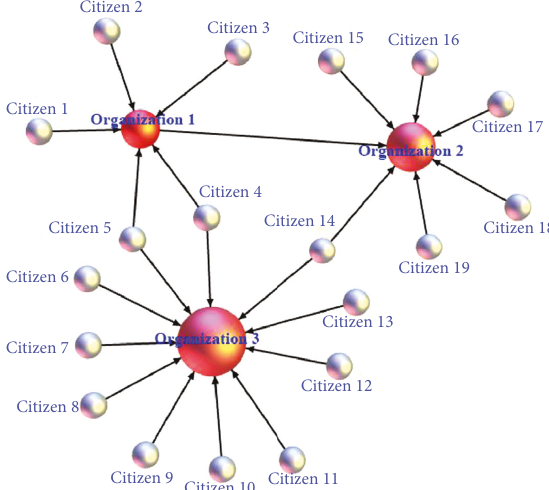
Figure 1: A complex network of citizens and government orga- nizations and